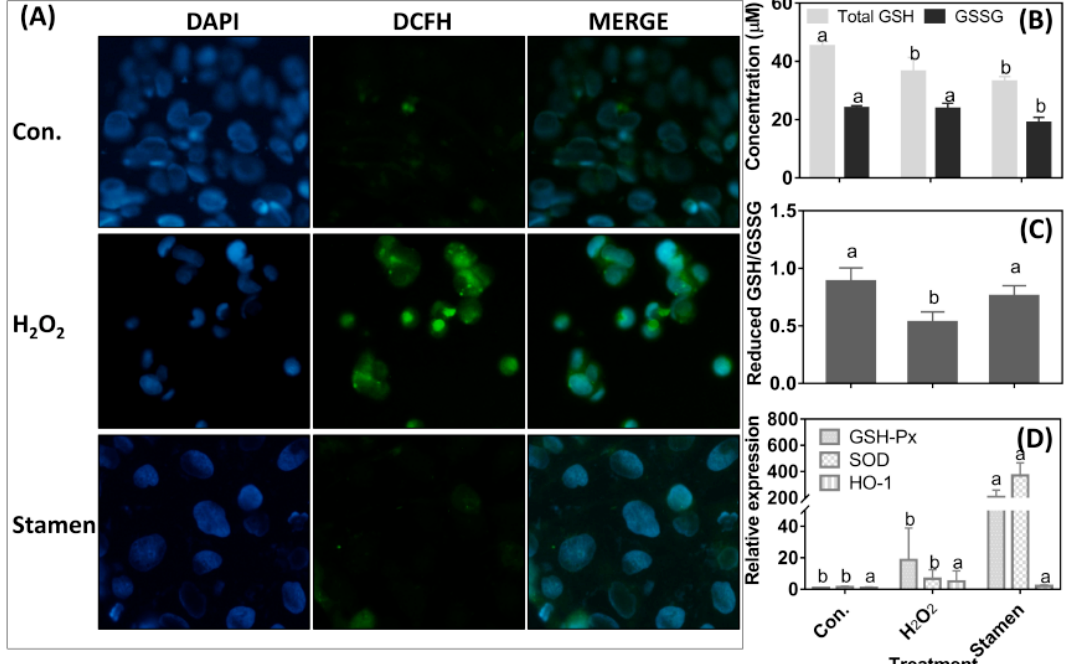
Figure 4. The effect of total phenolic extract (TPE) from stamen on reactive oxygen species (ROS) production ( A ), glutathione (GSH) content ( B ), the ratio of reduced GSH / GSSG (glutathiol) ( C ), and antioxidative enzymes expression ( D ) of Caco-2 cell under H 2 O 2 treatment. Cells were treated for 1 h with 2.0 mM H 2 O 2 , and then treated for 4 h with 1 μ g/mL TPE from the stamen. For H 2 O 2 treatment, cells were first treated with 2.0 mM H 2 O 2 for 1 h and then treated with a regular medium for 4 h. DCFH: 2 ′ ,7 ′ -Dichlorofluorescin, DAPI: 4 ′ ,6-diamidino-2-phenylindole. The con. means negtive control (no H 2 O 2 or TPE treatment). The magnification in Figure ( A ) is 40×. Data are expressed as mean ± SD. Different lower case letters indicate the significant differences at p < 0.05 for each parameter.